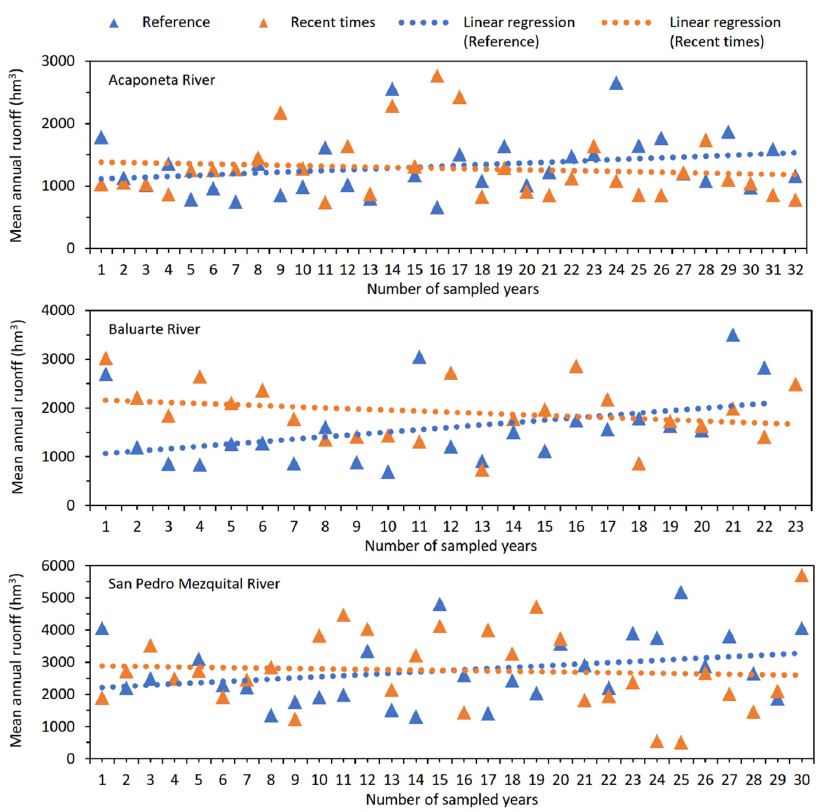
Figure A4. Trends of the mean annual runoff for two periods of observation from three highly variable flow regime rivers, Acaponeta ( top ), Baluarte ( middle ), and San Pedro Mezquital ( bottom ). Periods of observations were split into two, the first as a reference (historical) (Acaponeta 1945–1976,